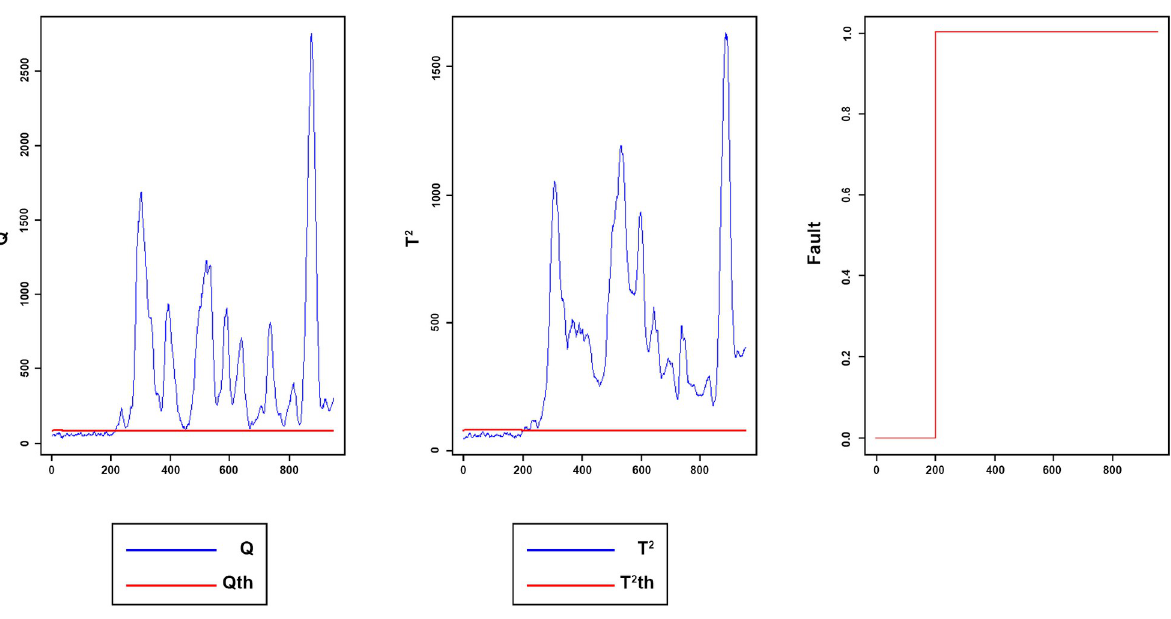
Fig 13. Monitoring performance of MWDPCA for fault 13.